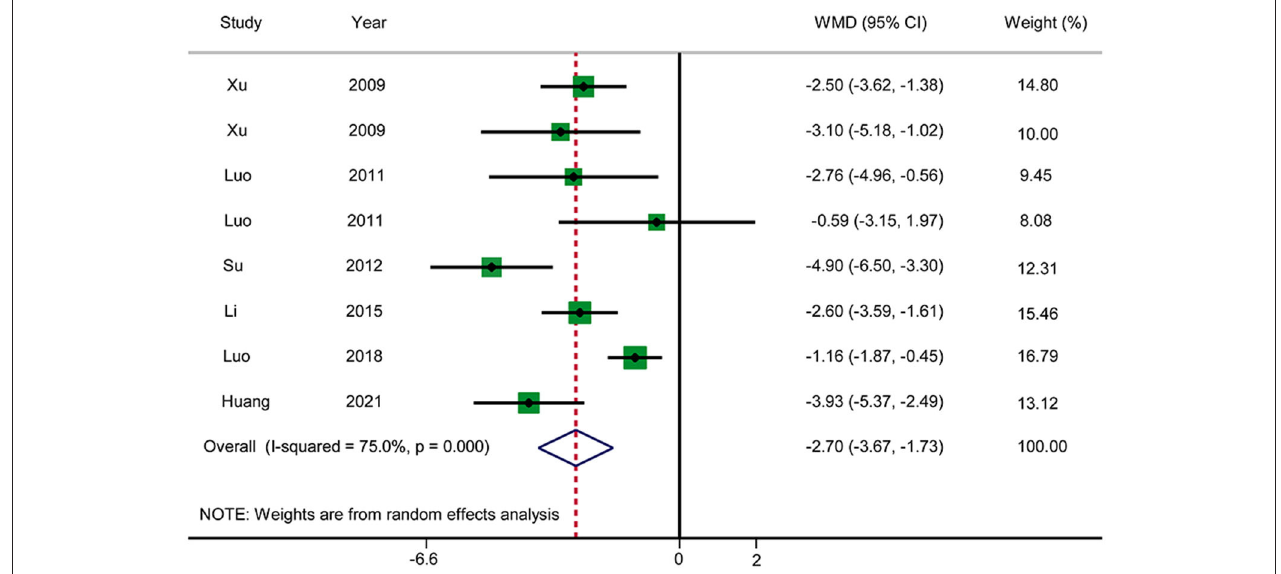
FIGURE 7 | Meta-analysis of time until relief of abdominal distension.